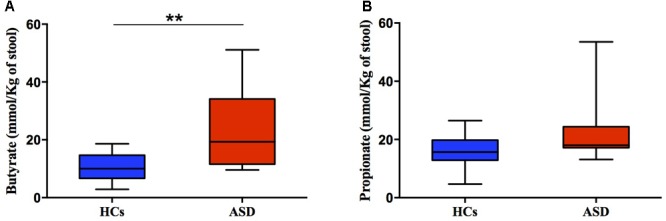
Fecal concentration (mmol/Kg) of butyric (A) and propionic acid (B) in ASD and HCs samples. ∗∗p < 0.01 for comparisons of ASD vs. HCs using Mann-Whitney test.